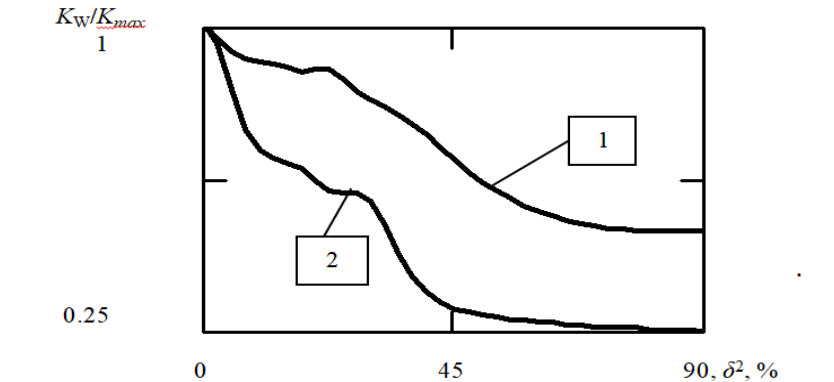
Fig. 3. K W dependence on errors in specifying the target reflection